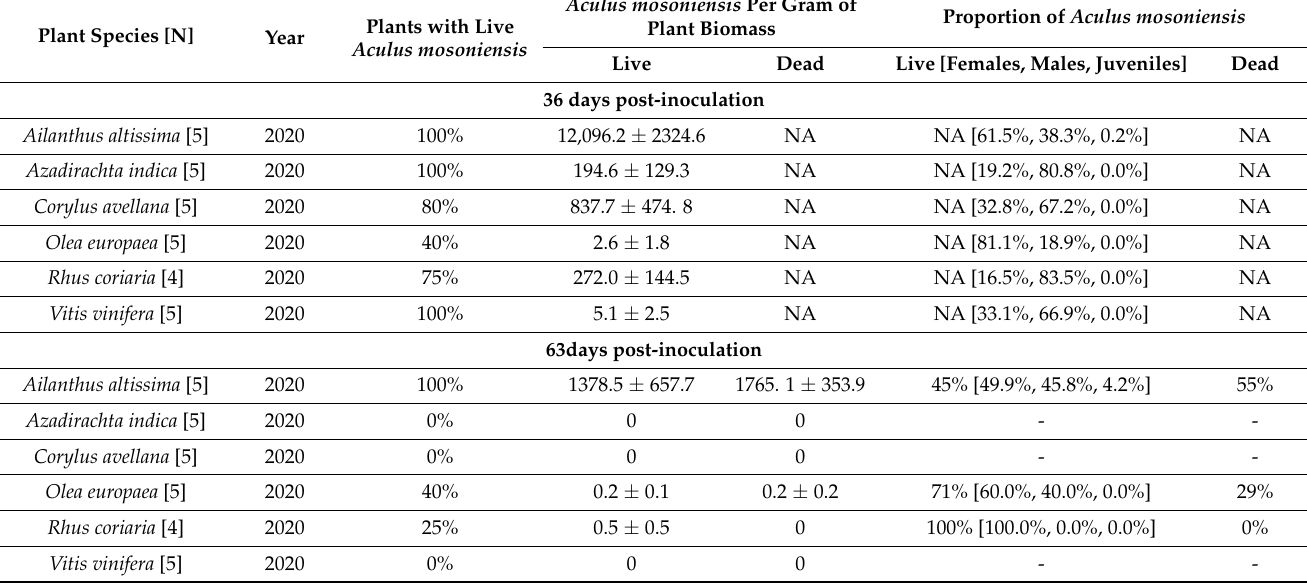
Table A2. Number of replicates for each plant species [N]; percentage of plants infested with live Aculus mosoniensis ; number of live and dead A. mosoniensis per gram of plant biomass (mean ± SE) collected from each plant species tested; proportion of live and dead A. mosoniensis , and of adult females and males, and juveniles among the live A. mosoniensis collected from each plant species tested, at different sampling dates (i.e., 36 and 63 days post-inoculation, respectively) in 2020. (NA—data not